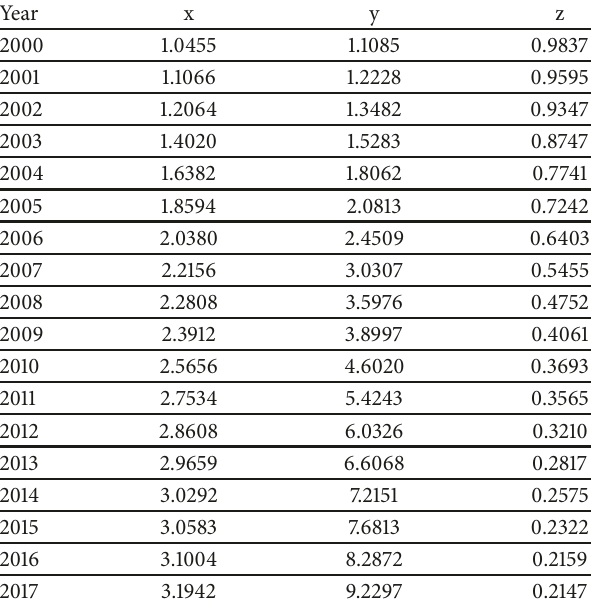
Table 1: Statistics on energy consumption, economic growth, and environmental quality in